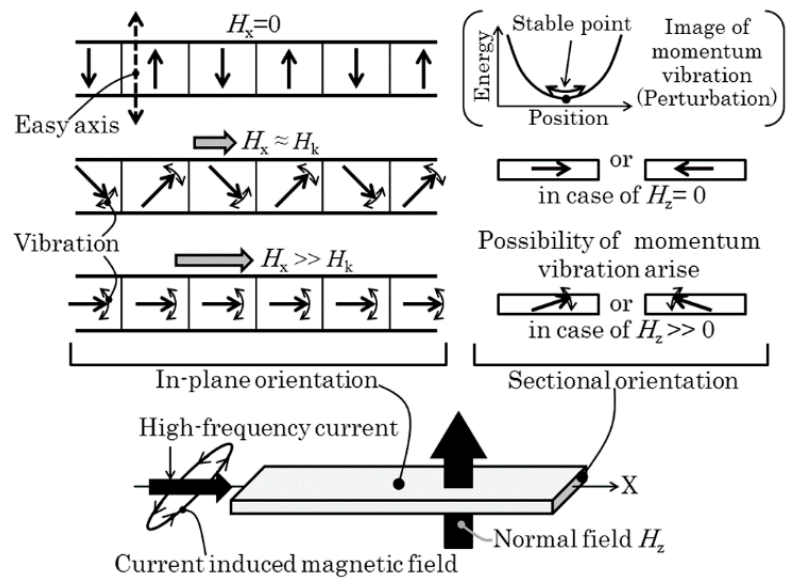
6 of 23 Figure 6. Explanation of interaction between the magnetized particle and thin film sensor in a ver- tical magnetic field [21]. The high-frequency impedance of the magneto-impedance sensor is well-known that it is caused by the skin-effect in the sensor element. The skin-depth of the current flow changes as a function of high-frequency permeability of the soft magnetic sensor element. In case of a frequency range which is larger than roughly MHz, the permeability appears based on a magnetization vibration, instead of the magnetic domain wall movement. Figure 7 indicates a schematic explanation of magnetization vibration in the thin film magneto-impedance sensor, when a surface normal field is applied. The left three figures show a variation of magnetic moment, in which the orientation and the vibration are in each cases of different external magnetic field along the sensor length direction. The upper right schematic explains a moment vibration as a perturbation around a stable state. The right sectional schematic explains the effect of demagnetizing force along the thickness direction. In this figure, the magnetic anisotropy field is shown as H k . The direction of easy axis of the magnetic anisotropy lies in width direction in this Figure. Based on our study, the domain variation depends on the eas y -axis direction. In case of the eas y -axis directing along the in-plane inclined direction, a domain wall movement appears and the area ratio of the contiguous domain changes as a function of applied field. The applied field is in the direction of element’s longitudinal axis. The left schematic of Figure 7 is the case which has the eas y -axis in an ideal width direction. The domain width in our Co